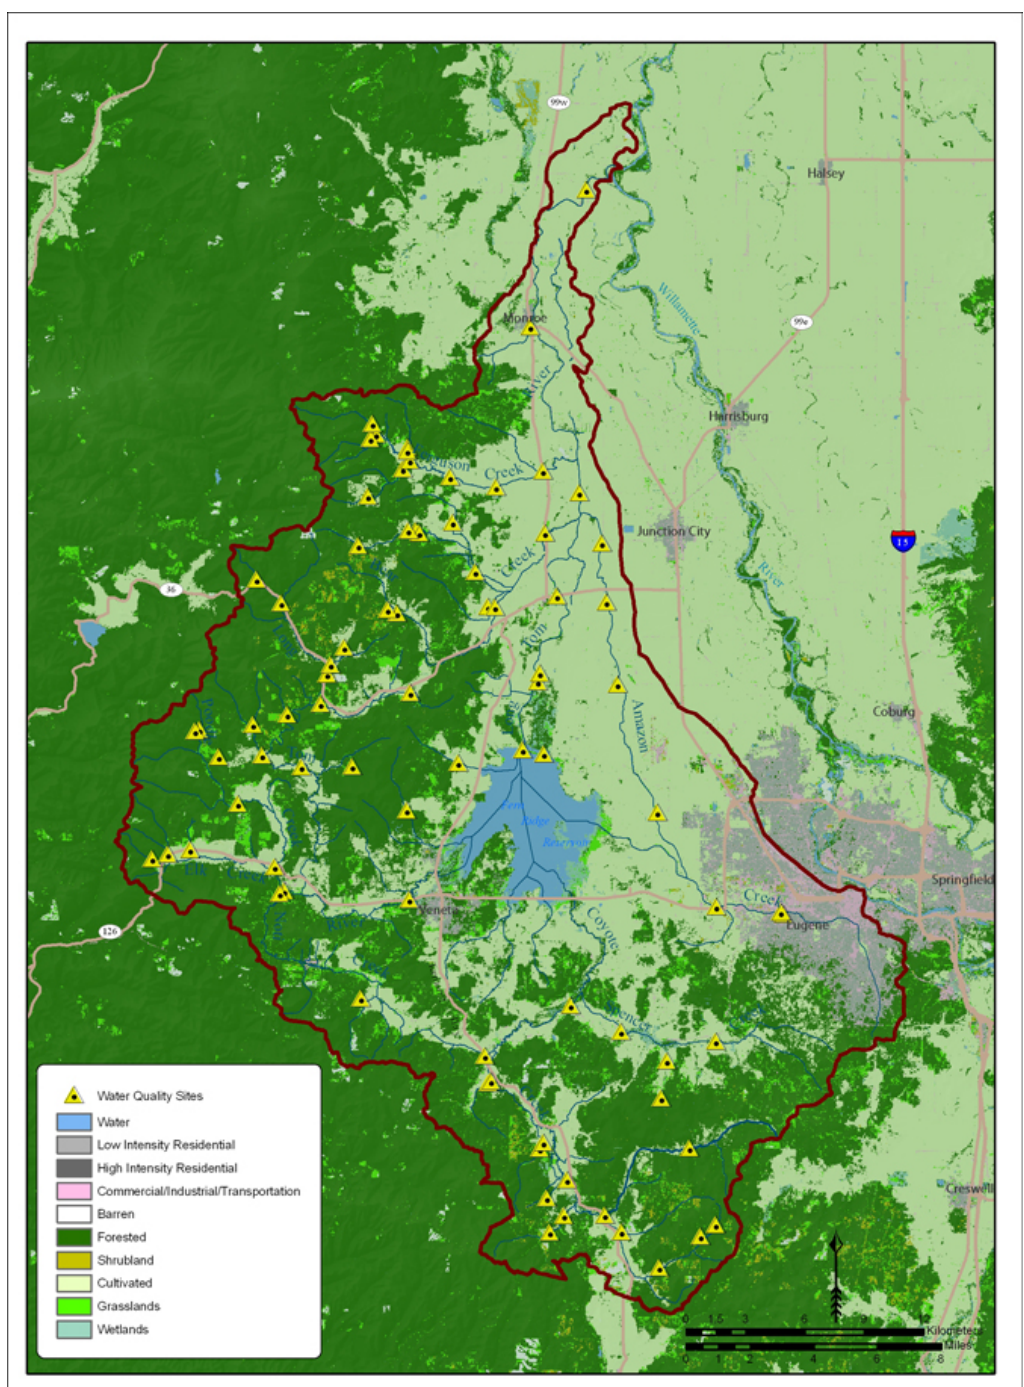
Fig. 2. Land cover for the Long Tom River Watershed and water-quality sampling